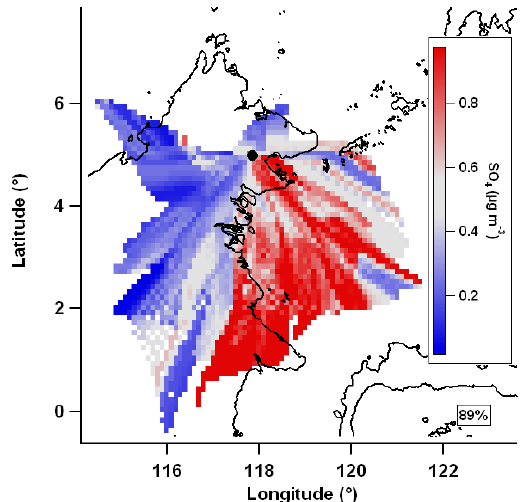
Fig. 15. Sulphate mean value map. Grey is median value, red is greater than median, blue is less than median and white denotes no data coverage. 36h trajectories are used.